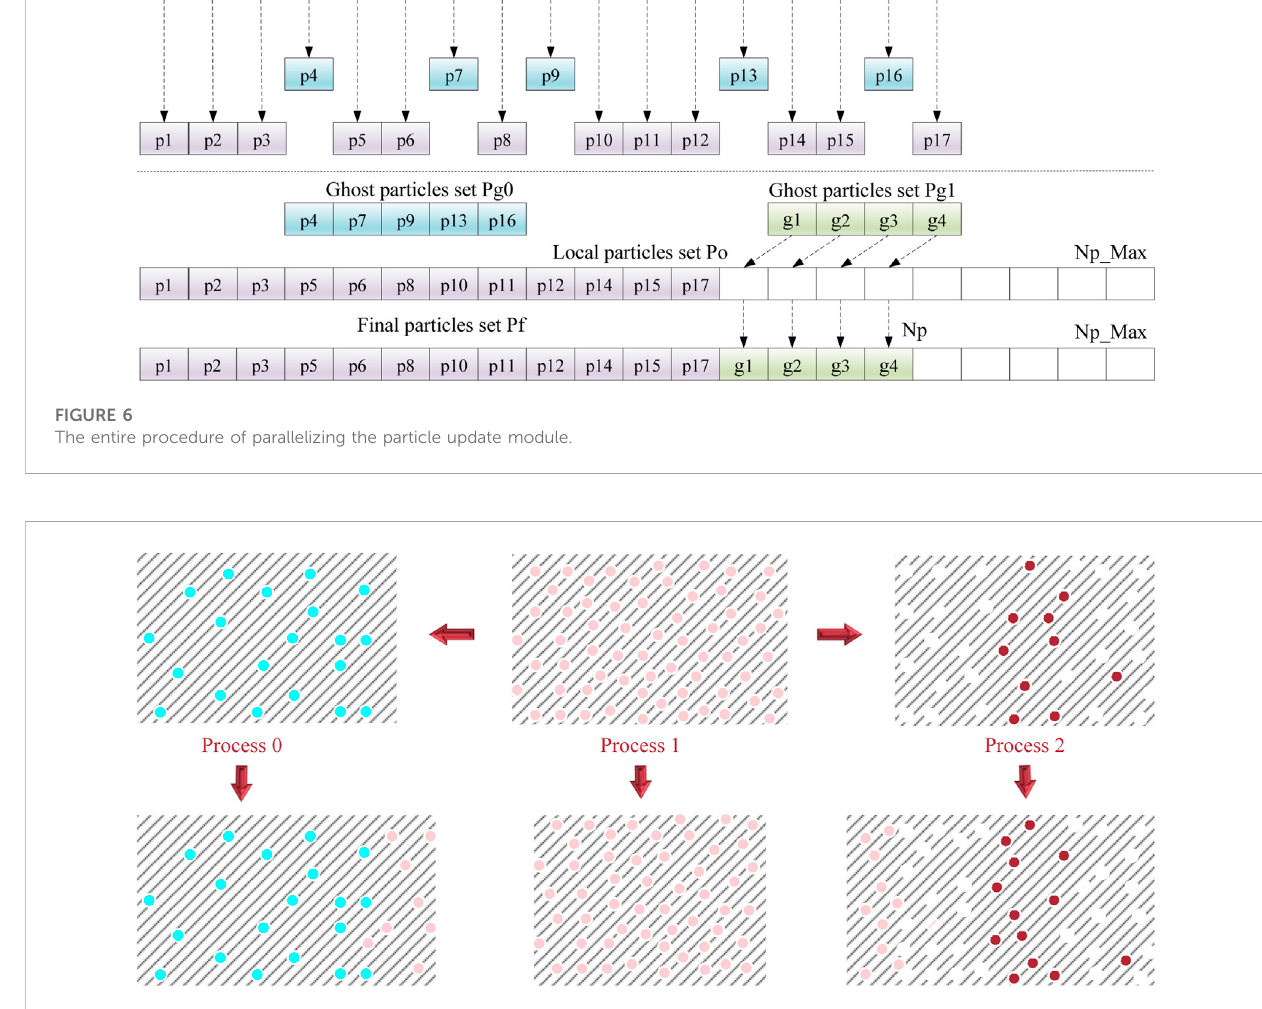
FIGURE 7 The principle of dynamic adjustment of particles in three adjacent